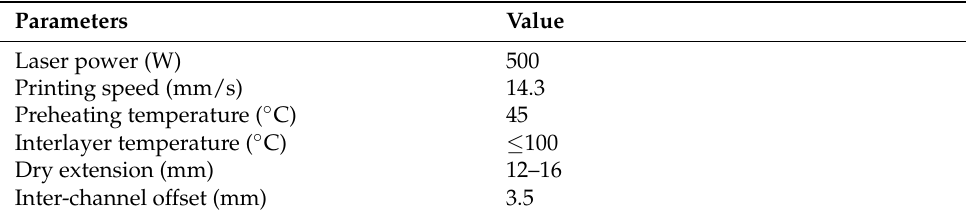
Figure 1. The schematic of SLM processing. Table 2. The parameters of the 316L SS additive manufacturing process.